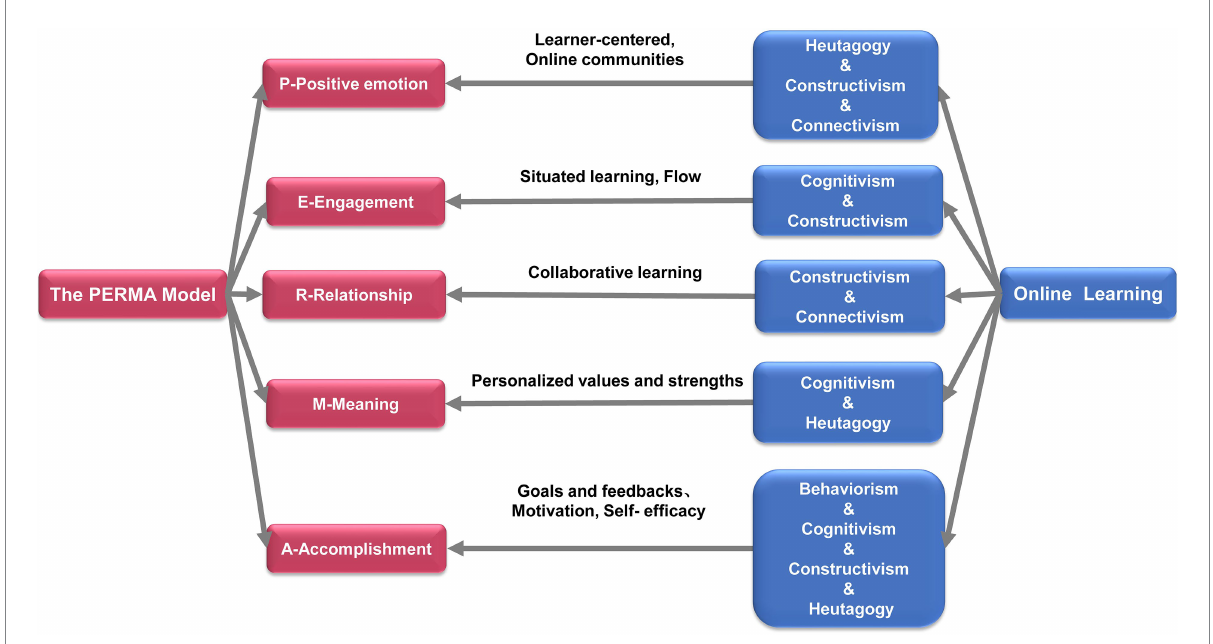
FIGURE 1 How does online learning promote the development of positive